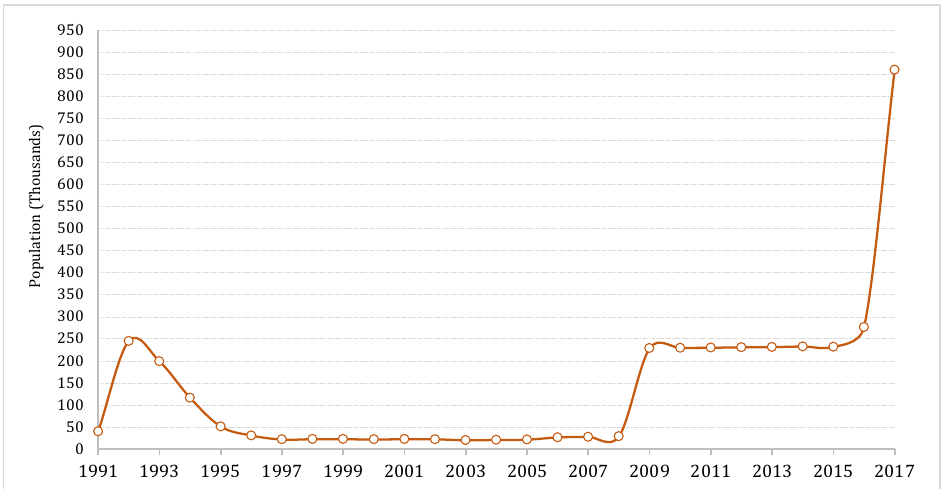
Figure 1. Number of Rohingya refugee influxes in Bangladesh from 1991 to 2017 (cumulative number of refugees including pre-influx population). Data for the period of 1991–2016 were retrieved from United Nations High Commissioner for Refugees (UNCHR) [35], and refugee population data for the year of 2017 were obtained from Inter Sector Coordination Group (ISCG) [36].